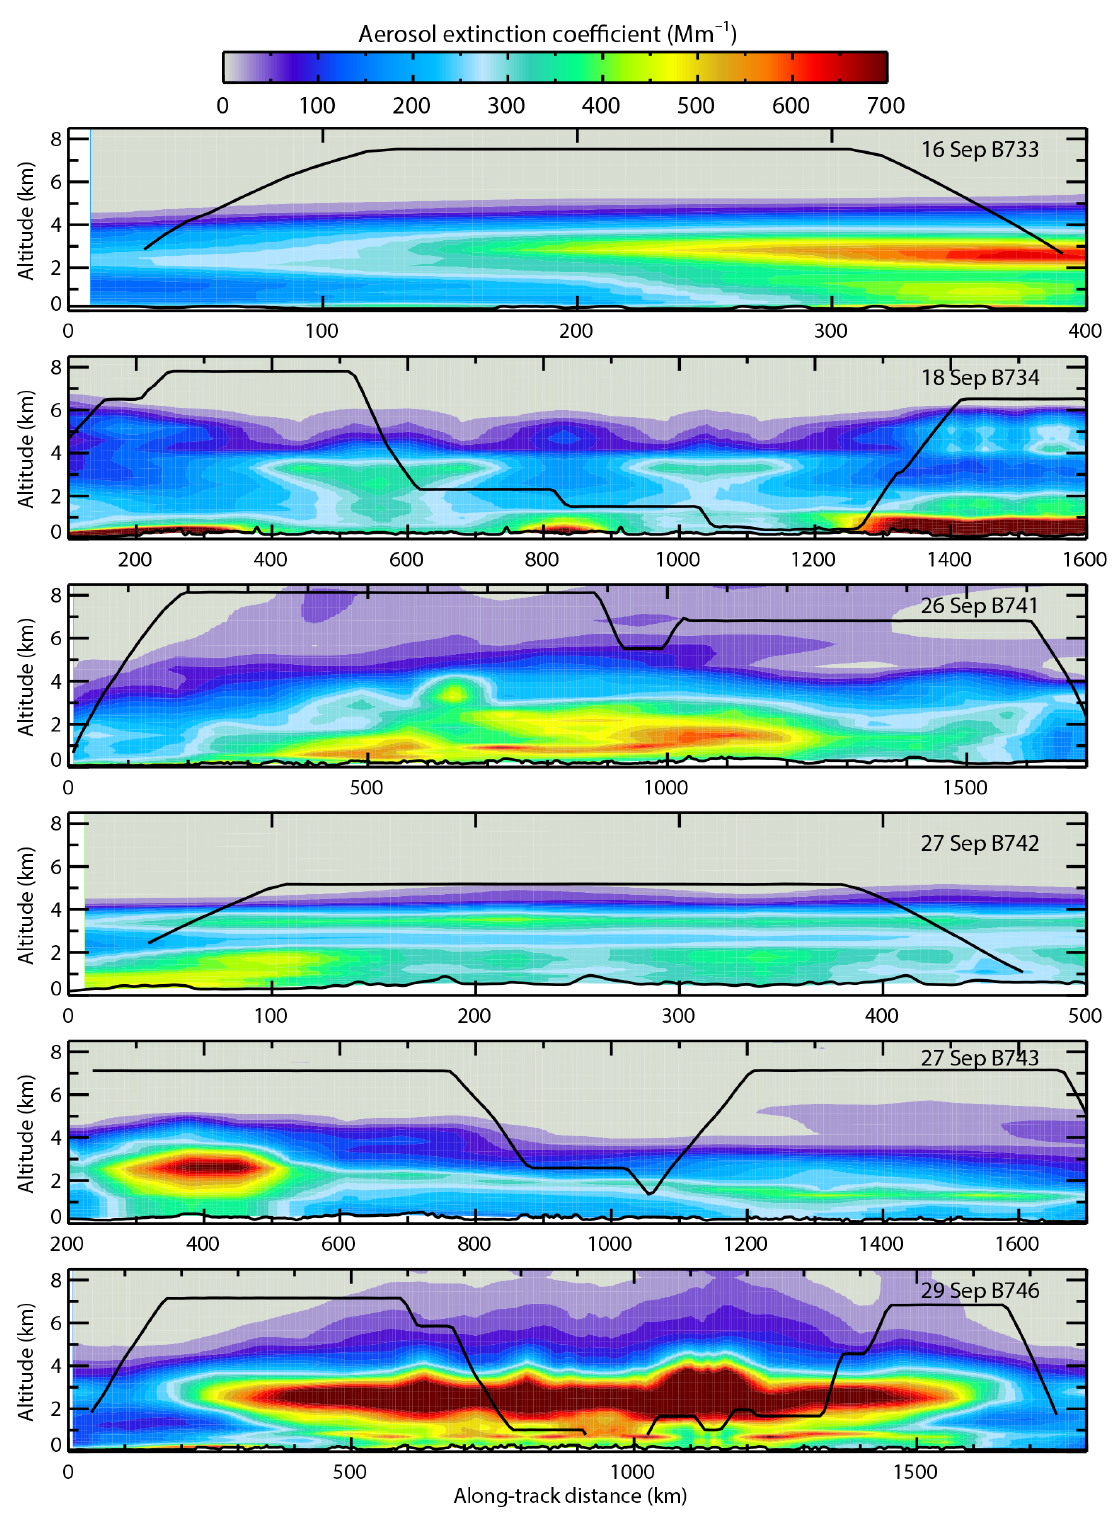
Figure 11. Cross-sections of the aerosol extinction coefficient estimated from the ECMWF-MACC model, along the tracks of the six research